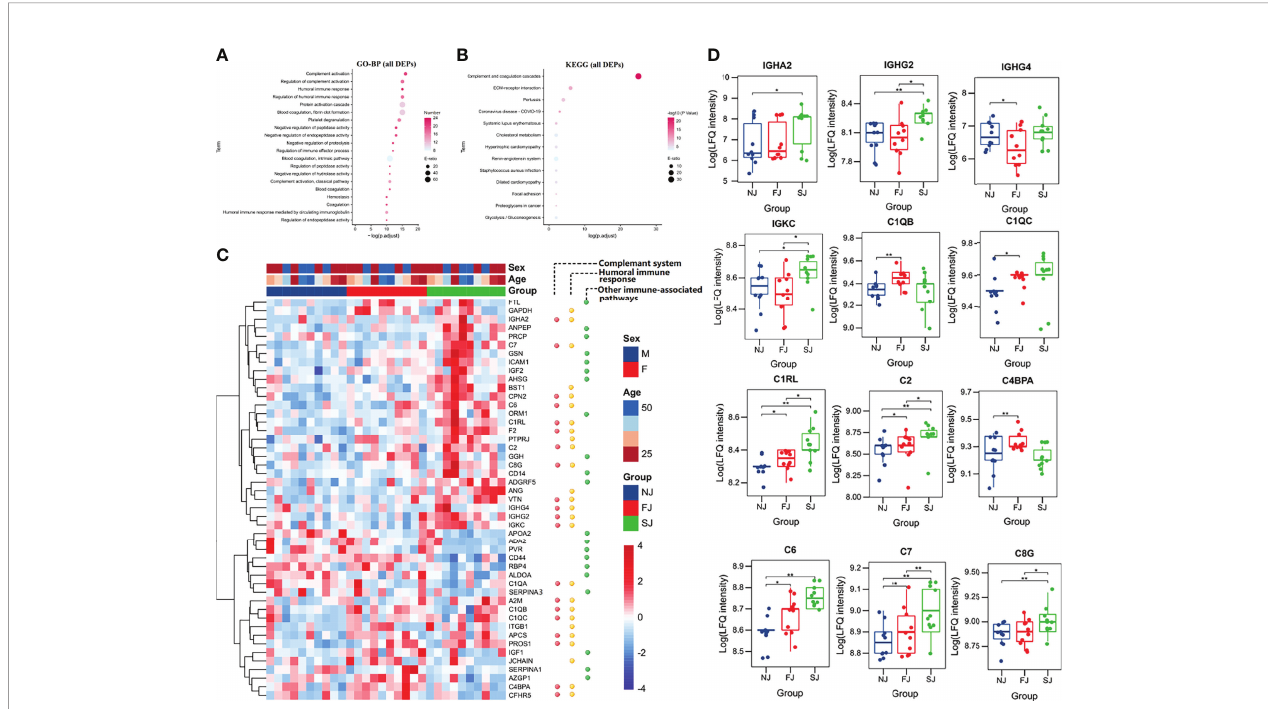
FIGURE 2 | Enrichment and Distribution of Immune Related Proteins. (A) GO-BP analysis of the total DEPs from FJ vs NJ and SJ vs NJ. Top 20 GO-BP terms were expressed. (B) KEGG pathway analysis of the total DEPs from FJ vs NJ and SJ vs NJ. Top 12 KEGG terms were expressed. (C) Heatmap of selected proteins from three enriched pathways: complement response, humoral immune response, and other immune associated-pathways. (D) The expression level comparison of humoral immune and complement related proteins with signi fi cant differences. Statistical signi fi cance was determined by two-sided paired Welch ’ s t test. *p < 0.05; **p <